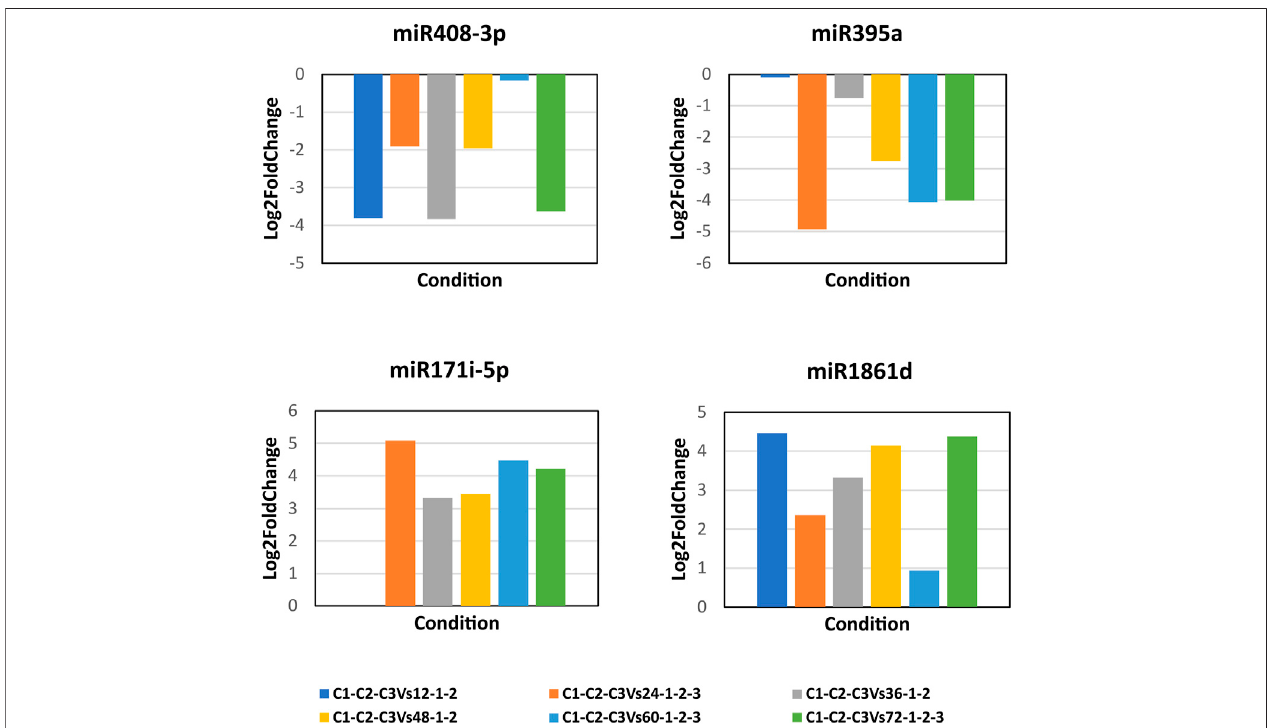
FIGURE 4 | Bar plots of the candidate miRNA log 2 fold change expression values. The bar plots represent the log 2 fold change expression values of the candidate miRNAs at 12, 24, 36, 48, 60, and 72 h post-infection of R. solani with respect to control samples. X-axis represents the condition (control vs. infection time point), and Y-axis represents the log 2 fold change expression values calculated by DESeq. miR408-3p and miR395a show the downregulation, whereas miR171i-5p and miR 1861d show the upregulation upon R. solani